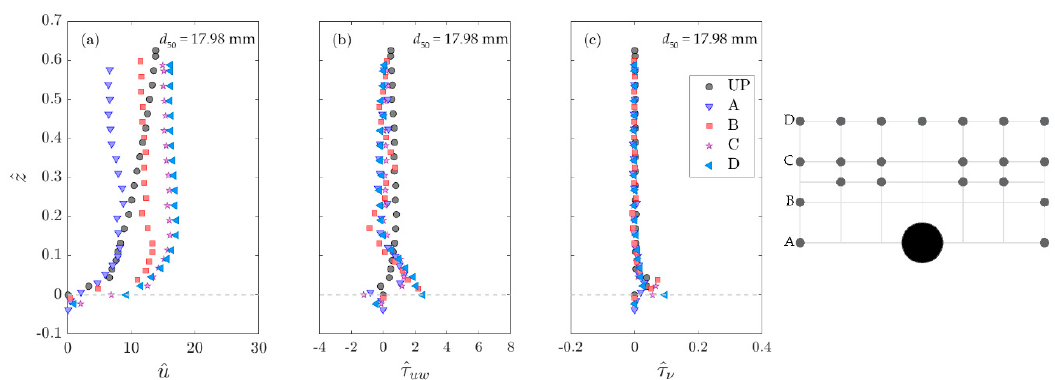
Figure 16. Vertical distributions of ( a ) dimensionless time-averaged velocity, ( b ) dimensionless Reynolds shear stress, and ( c ) dimensionless viscous shear stress measured at x = 0 in Run 3.